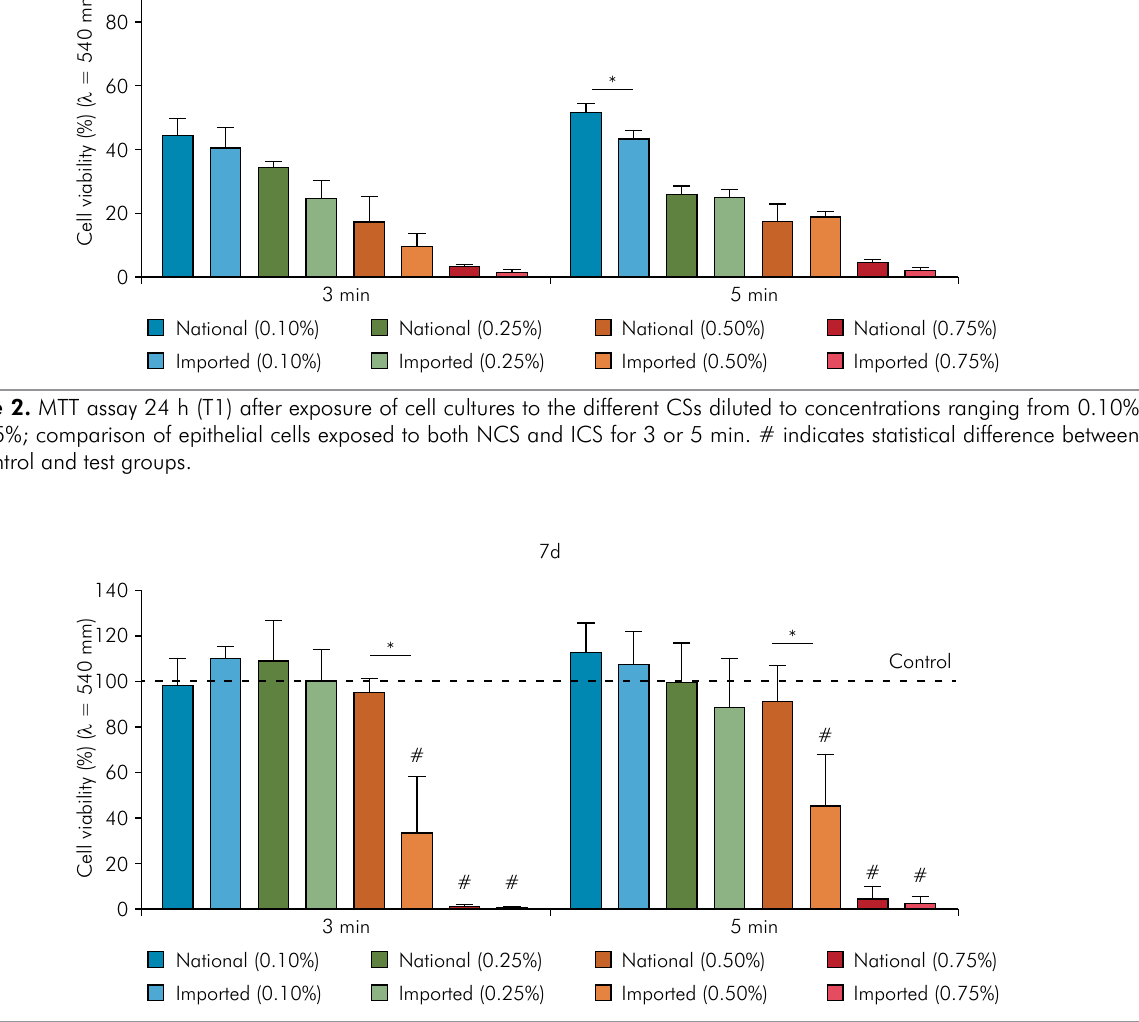
Figure 3. MTT assay 7 days (T2) after the exposure of cell cultures to the different CSs diluted to concentrations ranging from 0.10% to 0.75%; comparison of epithelial cells exposed to NCS and ICS for 3 or 5 min. # indicates statistical difference between the control and test